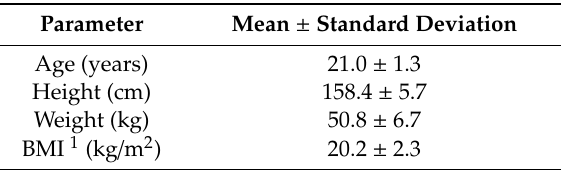
Table 1. Participant characteristics ( N = 65).